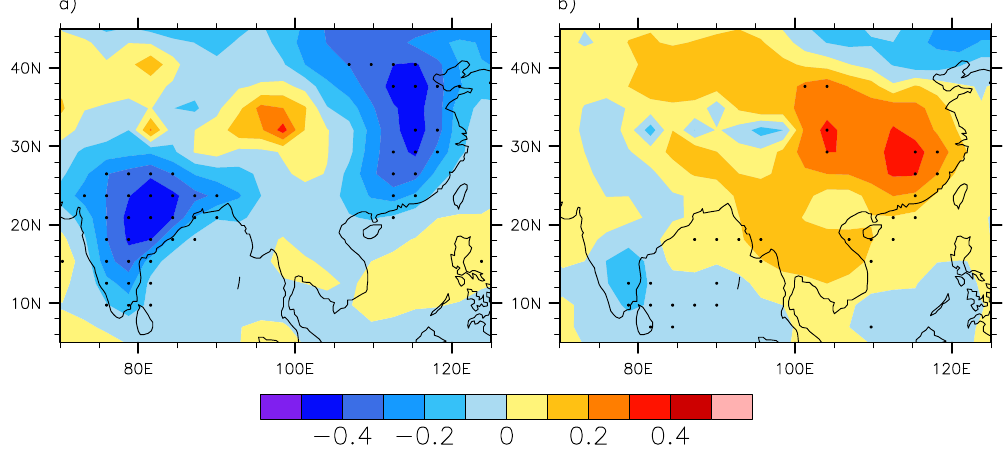
Fig. 4 Simulated regional climate responses to aerosol forcing between 2006 and 2014. Changes in annual mean surface air temperature using a CEDS and b PKU inventories (units: K). The stippled represent changes that are signi fi cant at 90% con fi dence level using the t EC using both inventories (CEDS: − 0.8 W m − 1 vs. PKU: + 0.7 W (Fig. 3d). Simulated AA ERF over EC in summer is − 1.6 W m − 1 for CEDS inventory, but the corresponding value reaches up to + 2.5 W m − 1 for PKU inventory.